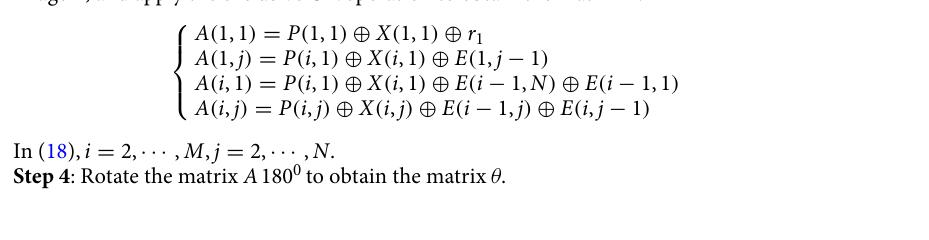
Figure 11. Attractor diagrams of x 1 diagram of the x 1 When i ( 3 ) circuit simulation diagram of the x 1